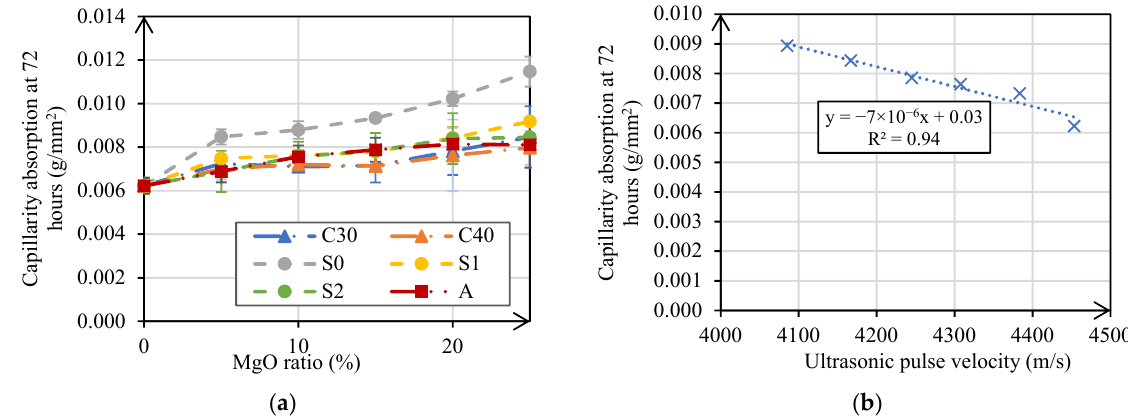
Figure 10. Water absorption by capillarity at 72 h versus MgO content ( a ); ultrasonic pulse velocity versus water absorption by capillarity ( b ).